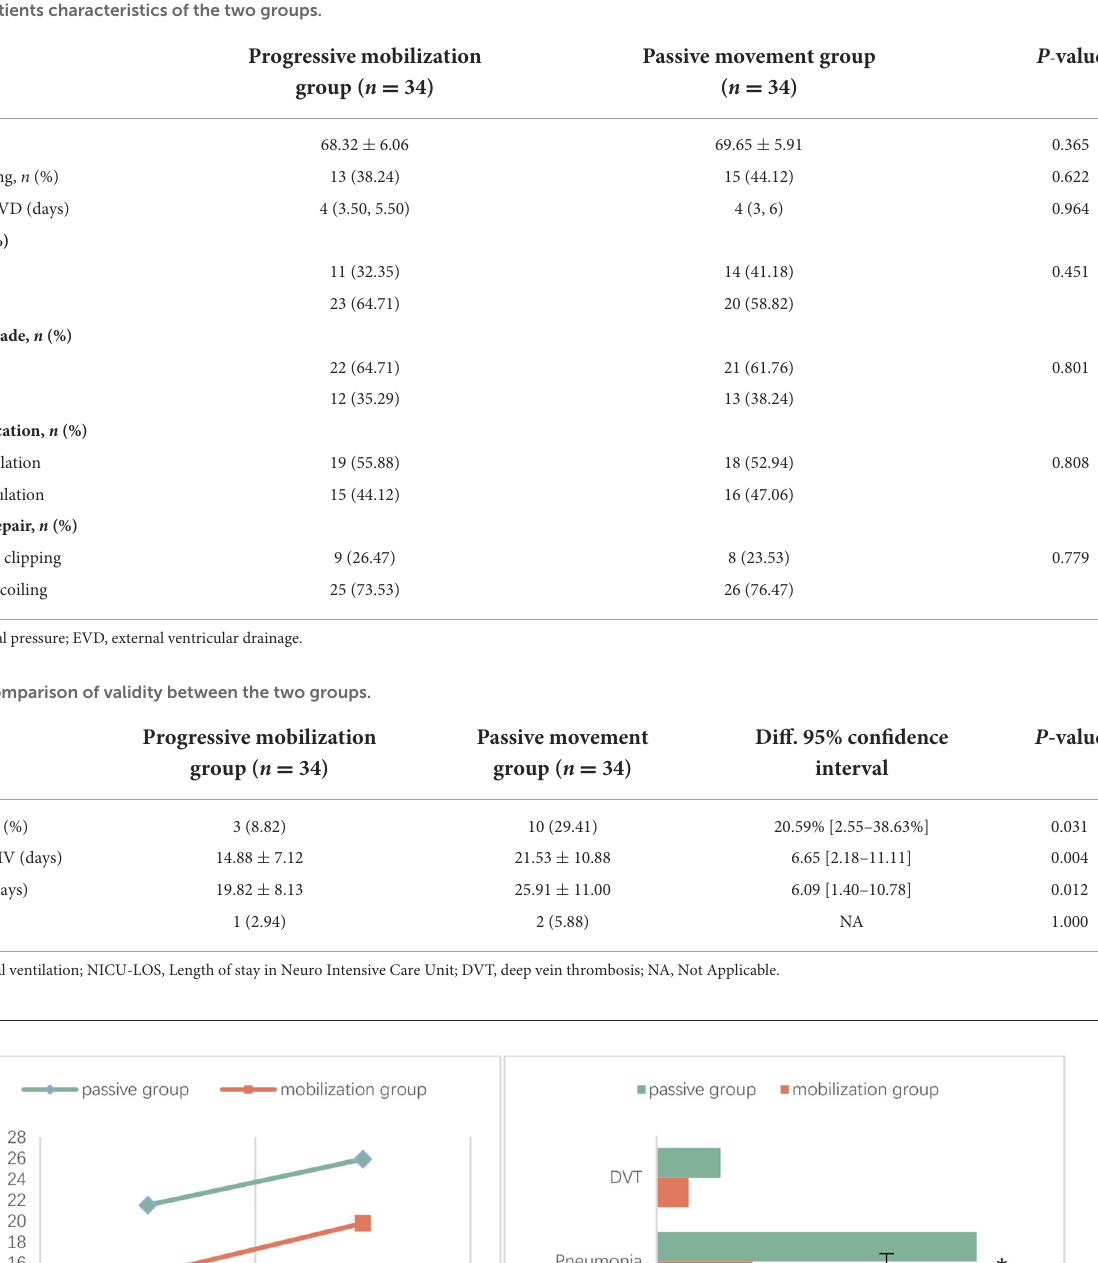
TABLE 1 Patients characteristics of the two groups.